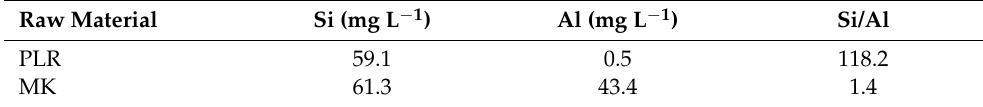
Table 4. Concentration of Si, Al, and Si/Al molar ratios in NaOH solution *. Raw Material